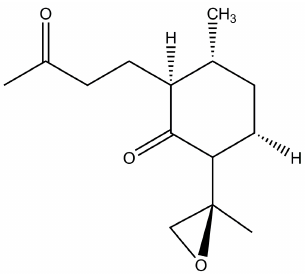
Figure 3. Chemical structure of arteannuin X [64].